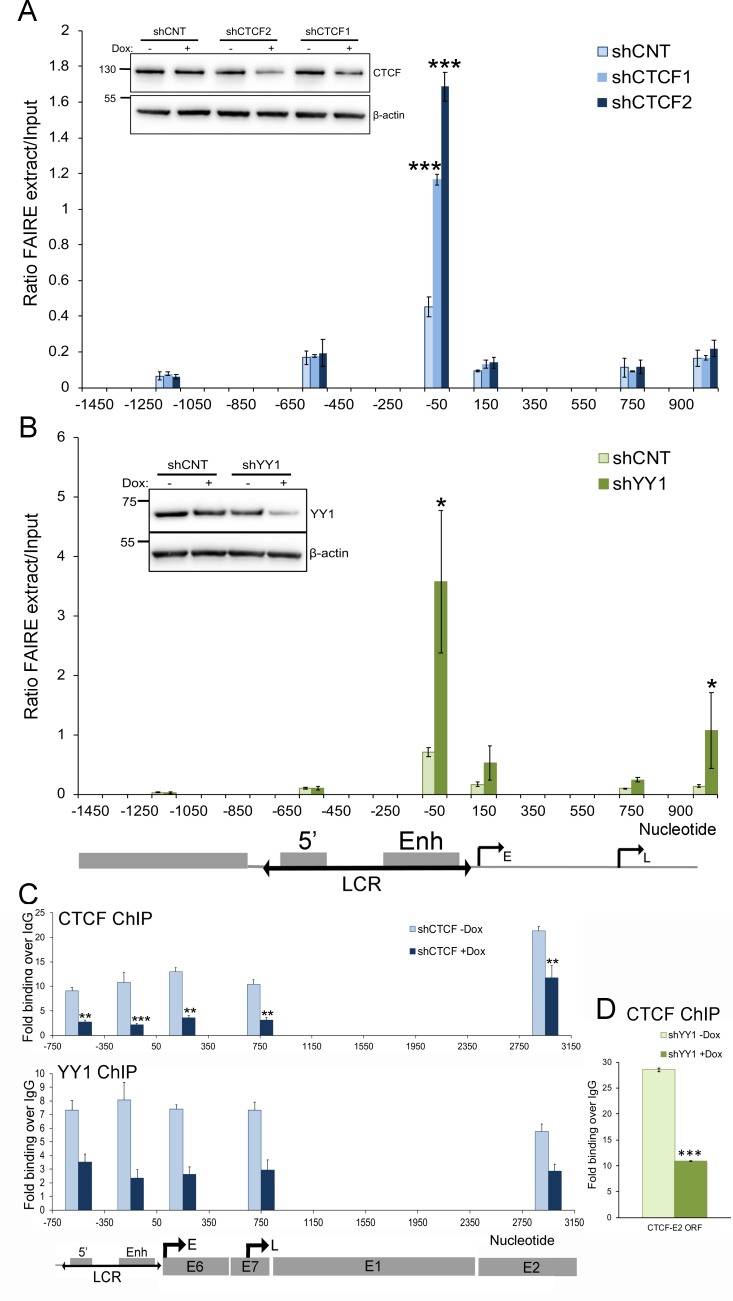
Depletion of CTCF or YY1 results in increased chromatin accessibility within the HPV18 LCR.Chromatin topology was assessed by FAIRE as previously described. Depletion of CTCF (A; shCTCF1 and shCTCF2) and YY1 (B; shYY1) protein in WT HPV18 genome containing cells is shown in the inset panels in comparison to shCNT. Data show mean ± SD of qPCR analysis of FAIRE-extracted samples of representative experiments performed in triplicate. Each experiment was performed at least three times with similar results. (C) Recruitment of CTCF (upper panel) and YY1 (lower panel) to the viral LCR and E2–CTCF binding site following Dox induction of shCTCF was assessed by ChIP-qPCR, and (D) recruitment of CTCF to the E2 ORF following shYY1 induction was assessed by ChIP-qPCR. Data show mean ± SD. ***p < 0.001, **p < 0.01, *p < 0.05 in all experiments. All raw quantitative data are enclosed in S1 Data. ChIP-qPCR, chromatin immunoprecipitation followed by quantitative PCR; CTCF, CCCTC-binding factor; Dox, doxycycline; E, early promoter; Enh, enhancer; FAIRE, formaldehyde-assisted isolation of regulatory elements; HPV, human papillomavirus; IgG, immunoglobulin G; L, late promoter; LCR, long control region; ORF, open reading frame; qPCR, quantitative PCR; shCNT, nontargeting shRNA control; shRNA, short hairpin RNA; WT, wild-type; YY1, Yin Yang 1.